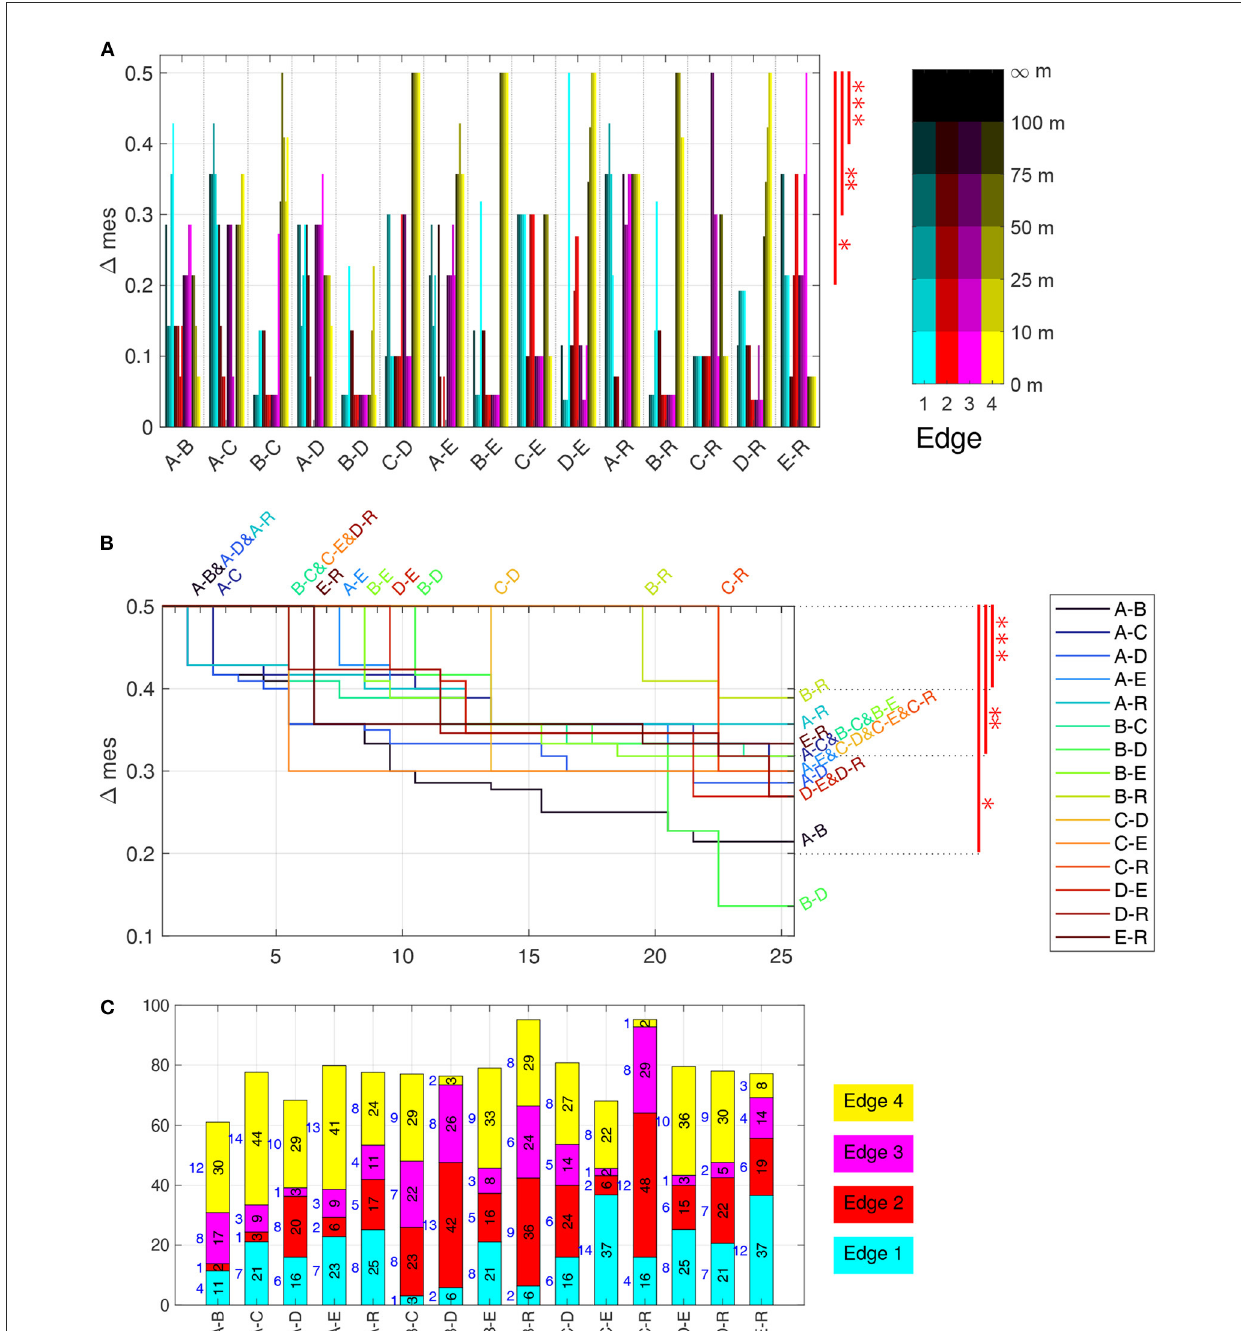
FIGURE9 Discrimination analysis based on time and flight angle near edges. (A) ∆ mes for the time spent in each of 20 vicinities of the edges, sorted by pair of groups. The three significance levels are shown in red on the right. For example, Groups C–D can be discriminated very well, while B–D cannot using only time near edges. (B) ∆ mes for the 25 best discrimination measures for each pair of bee groups, combining time near edges as well as angles. ∆ mes values (y-axis), sorted in decreasing order, with index 1 to 25 on the x-axis. As not all lines are visible everywhere, start and end are specified above and to the right, respectively. The three significance levels are shown in red on the right. For example, Groups C–D can be discriminated extremely well with 13 measures at the maximal ∆ mes, but also B–D with 11 measures, which are all flight anle measurements, see (A) . (C) Number (in blue on the left of each bar) and sum (black and height of bar) of best ∆ mes values per group pair and edge of all discriminants shown in (B) . The height is scaled to 100%, which corresponds to 12.5, i.e., 25 times the maximal ∆ mes of 0.5. Significance levels: *** ∆ mes * ∆ mes 0.2. ≥